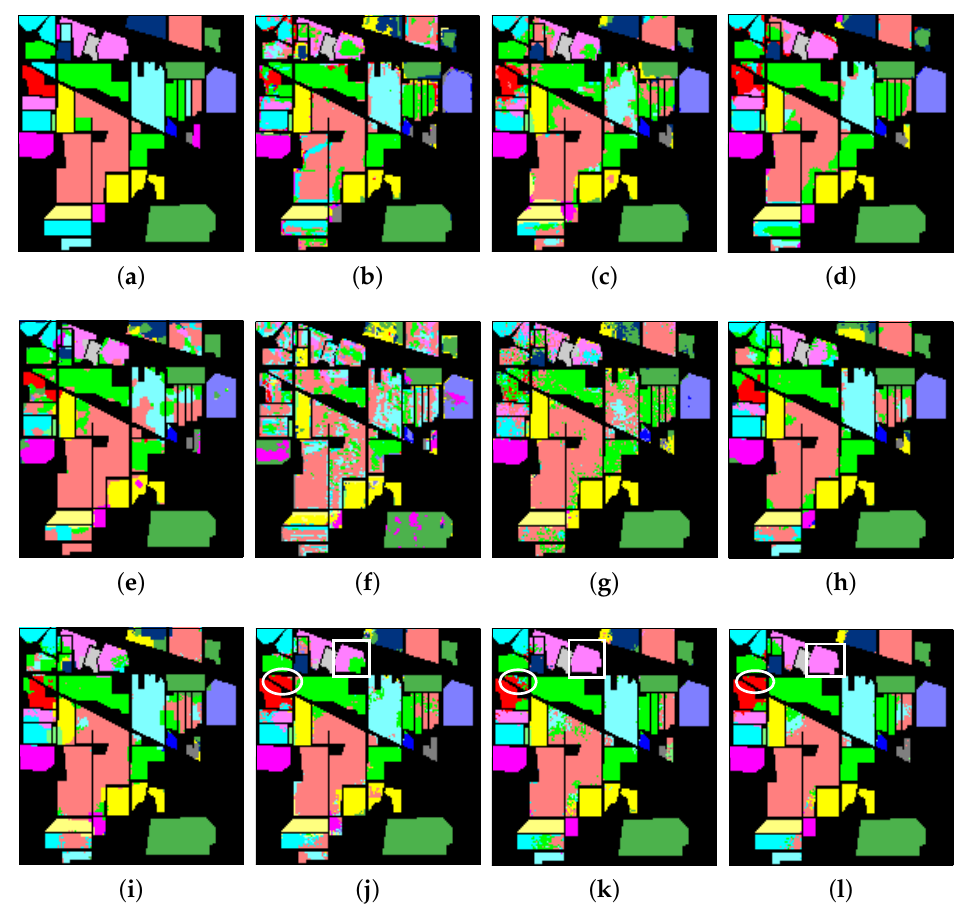
Figure 5. Classification maps on IP: ( a ) Groundtruth, ( b ) SVMCK, ( c ) LCMR, ( d ) LCEM, ( e )